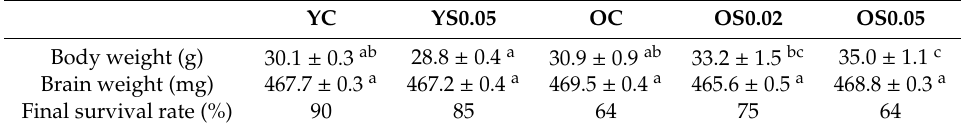
Table 1. Body and brain weights, and survival rates of young and old mice treated with sesame lignans or vehicle.